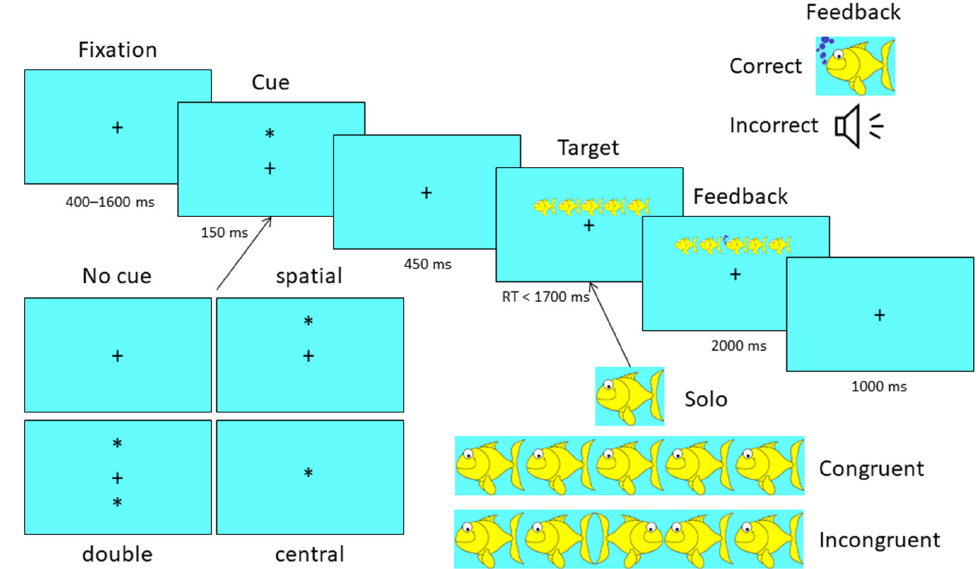
Figure 1. A depiction of the Attention Networks Test (ANT) displaying the four possible cues pre- sented in the lower left corner, the three possible Target conditions of solo, congruent and incongruent in the lower right corner and the correct vs. incorrect feedback conditions presented in the upper right corner. The + denotes the position on the screen at which the child is asked to fixate. The * denotes where the child’s attention should be directed for the Target stimulus. The blue circles denote the fish “eating” as a correct response. The colors of the background and the fish were chosen in the original task to engage children. The sequential boxes demonstrate the timing of the display of each component of the trial. The presentation of the cues and conditions are randomized across trials.